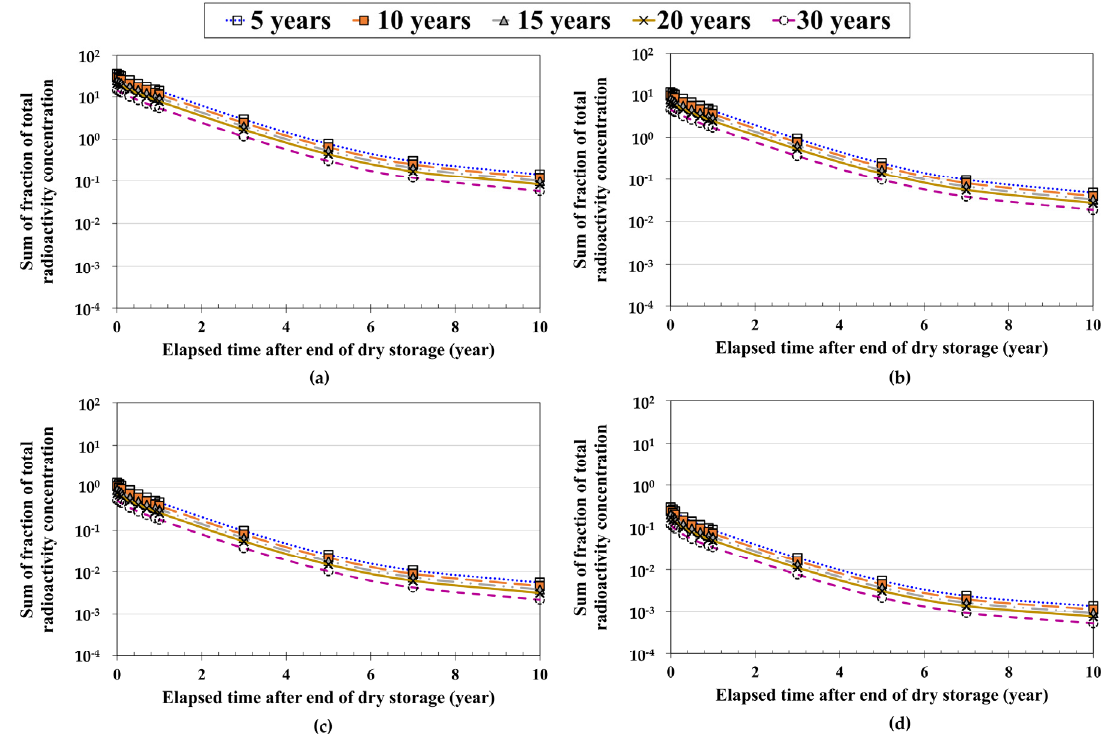
Figure 10. Sum of fractions of the estimated radioactivity concentration to the clearance level of each radionuclide, by varying fuel cooling times 5, 10, 15, 20, and 30 years after discharge from the reactor core, for each MPC-24 component: ( a ) basket, ( b ) shell, ( c ) baseplate, and ( d ) lid.